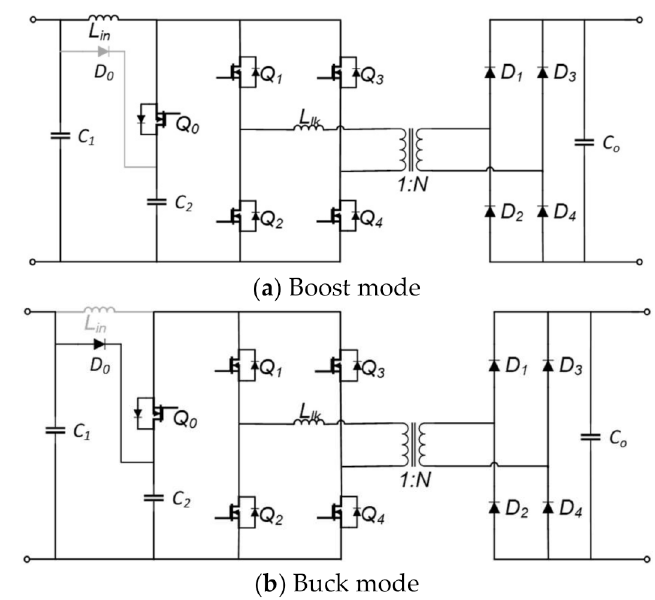
Figure 3. Equivalent circuit of the proposed isolated buck–boost